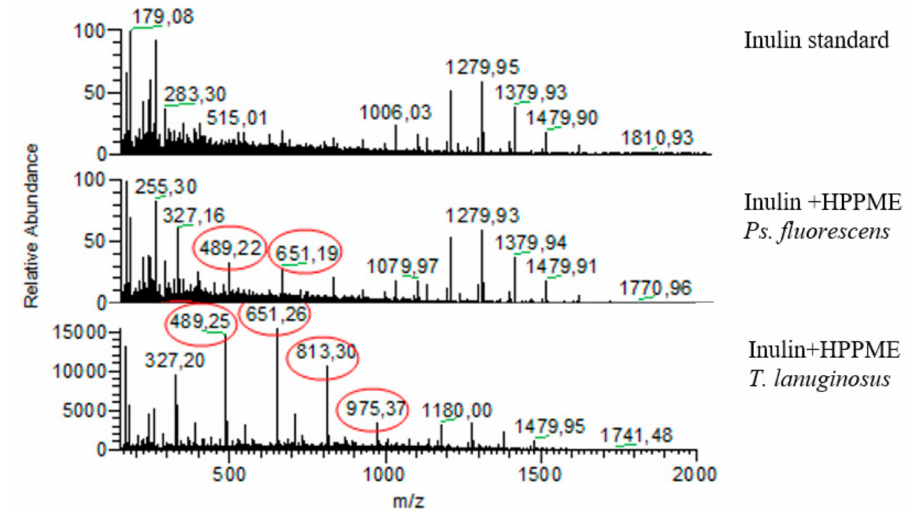
Figure 2. UHPLC MS spectra for inulin transesterification reactions with HPPME in 10% ( v / v ) DMSO / tert -butanol, catalyzed by lipases, at a 72 h reaction time. Red circles indicate the reaction products